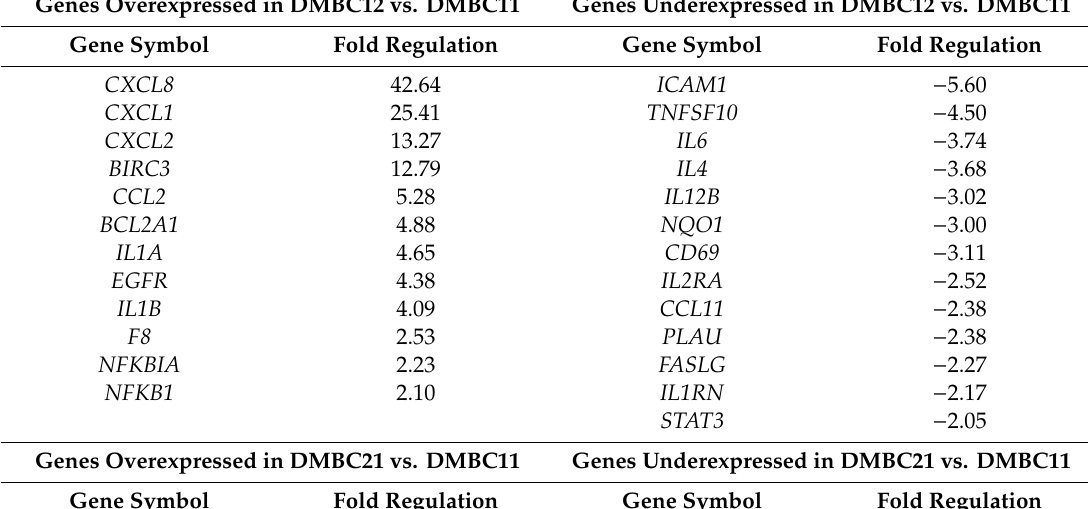
Table 1. Genes over- and underexpressed in DMBC12 and DMBC21 cell lines compared to DMBC11 cells. The cut-o ff fold change was set as